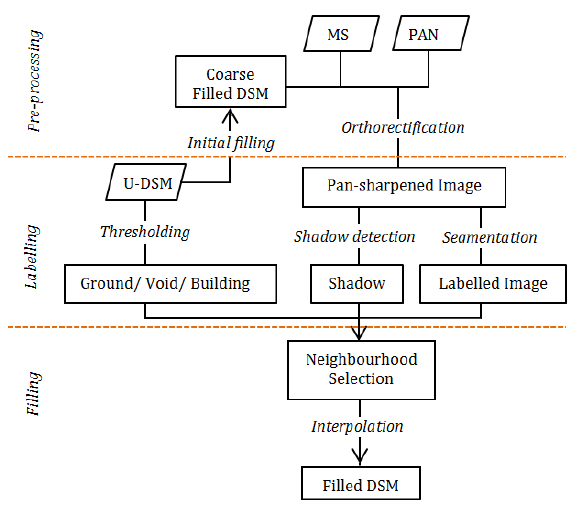
Figure 1. Flowchart of proposed